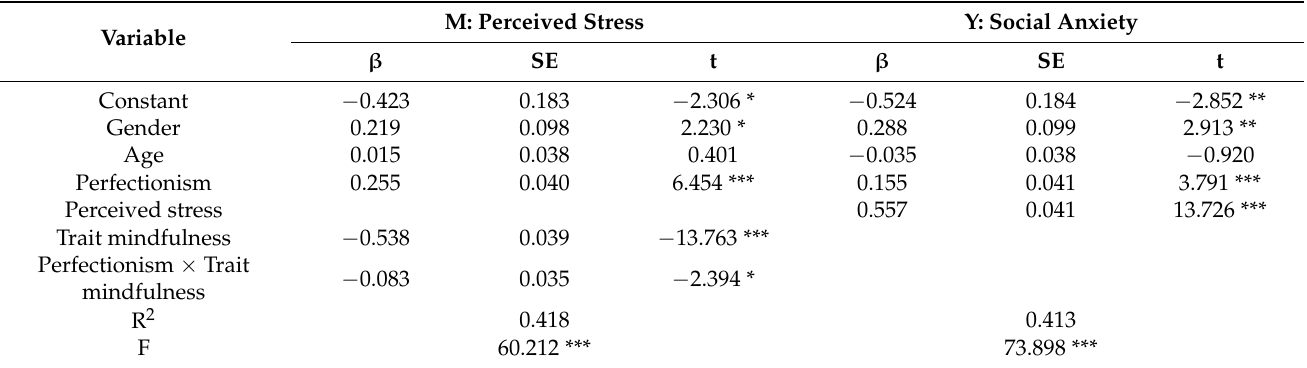
Table 2. The moderated mediating effect analysis of perfectionism on social anxiety (n = 425).